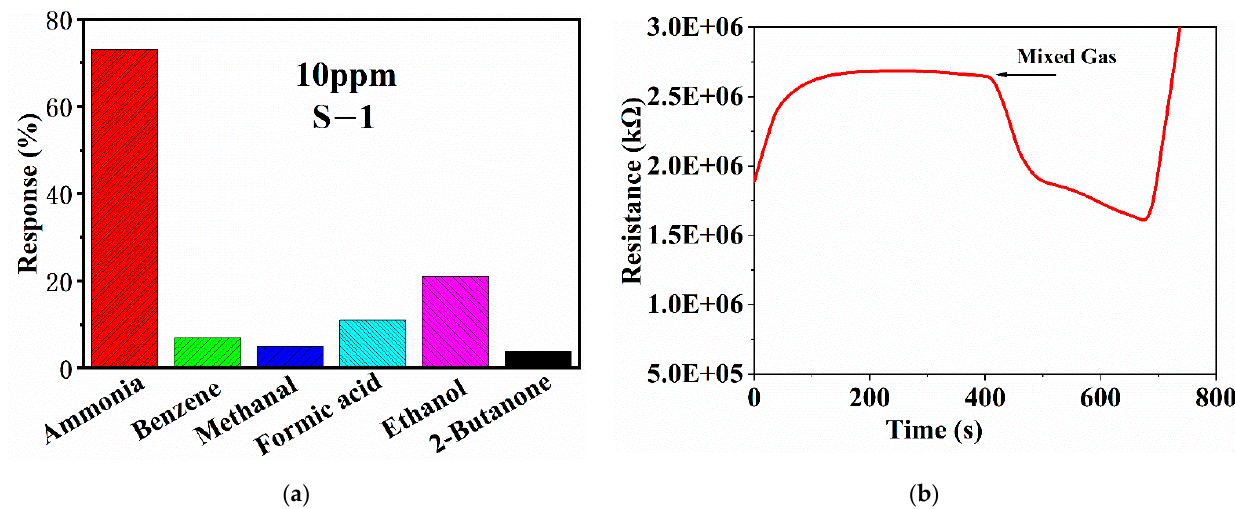
Figure 7. ( a ) Selectivity test of S-1, ( b ) response curve of S-1 to mixed gas. As shown in Figure 8, the repeatability of S-1 was tested in RT and 30% RH. First, 1 ppm ammonia was injected. After the reaction was stable, air was blown in, and the re- sistance of the sensor was restored. Then, 1 ppm ammonia was injected and the process was repeated three times. The test result showed that this kind of gas sensor has excellent repeatability.